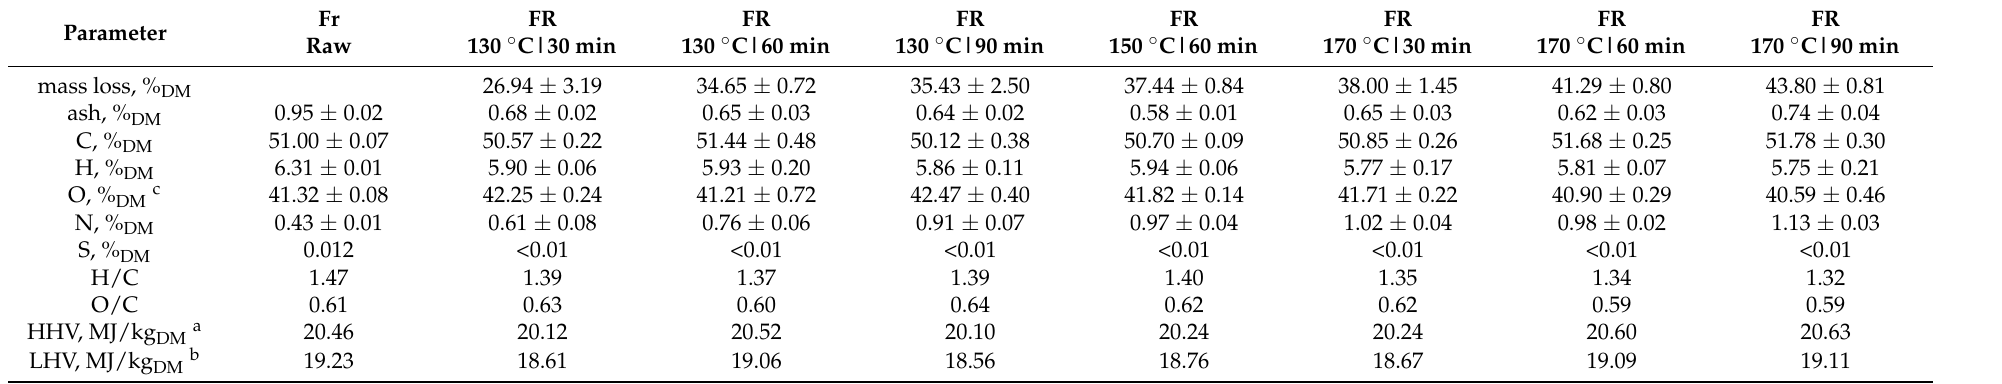
Table 4. Material properties of raw and hydrothermally treated forest residue (FR) at 130, 150 and 170 ◦ C with a holding time of 30, 60 and 90 min. The